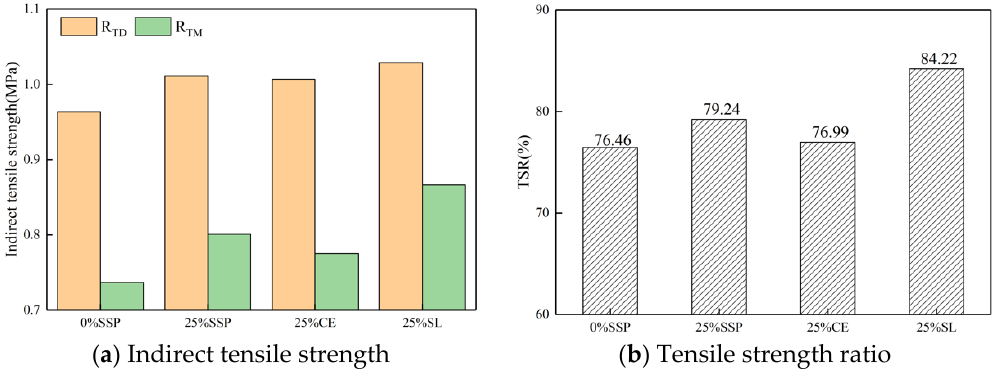
Figure 10. ITS and TSR of samples with different fillers with the same substitution.